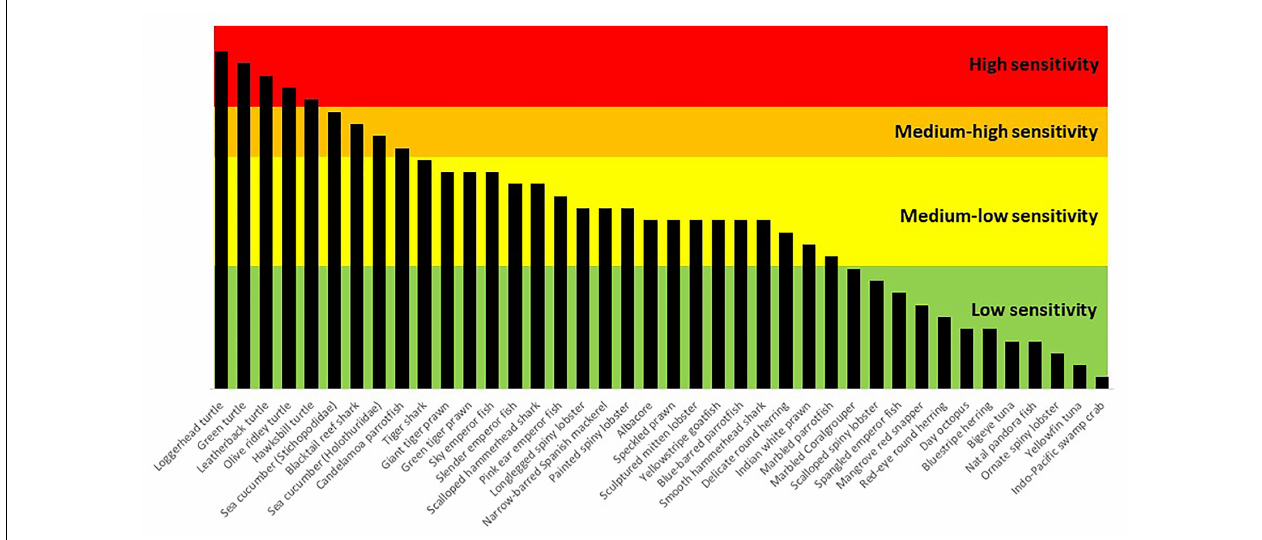
FIGURE 3 | Preliminary results of the Malagasy species sensitivity